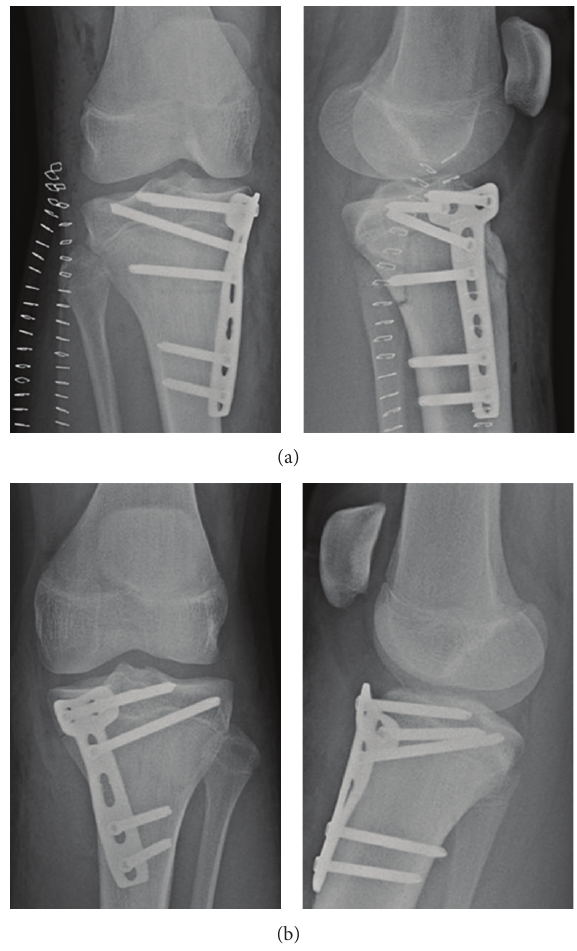
Figure 2: Plain radiographies of the right (a) and left knee (b) after closed reduction and MIPO using two 4.5 mm LCP t-plates placed at the anteromedial aspect of the tibia. Growth plates were bridged.